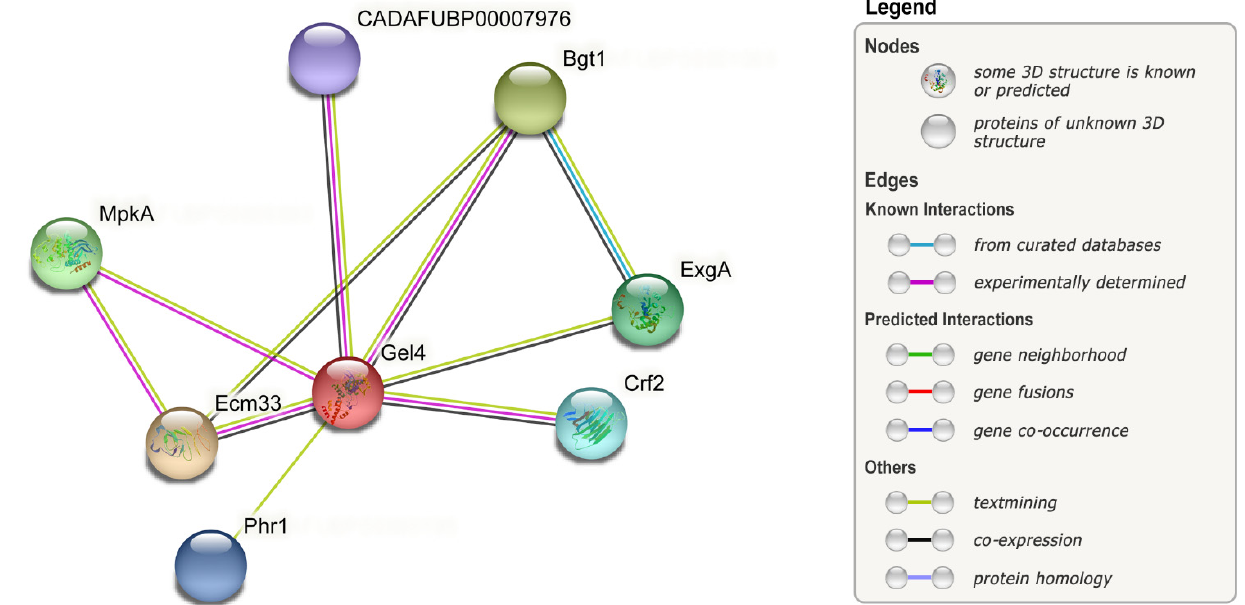
Figure 3. Protein interaction network of query protein Gel4 (red node) in Aspergillus fumigatus ( A. fumigatus ) (NCBI taxonomy Id: 746128) with reduced legend. Each node represents a protein. Filled nodes have a known or predicted 3D structure, whereas empty nodes do not. Edges represent protein–protein interactions and colors indicate known, predicted, or other interactions. The protein CADAFUBP0000 7976 is unnamed and has the protein accession code: XP_747364.1 Produced with the STRING tool (V11.5) [247] by K. Verburg.